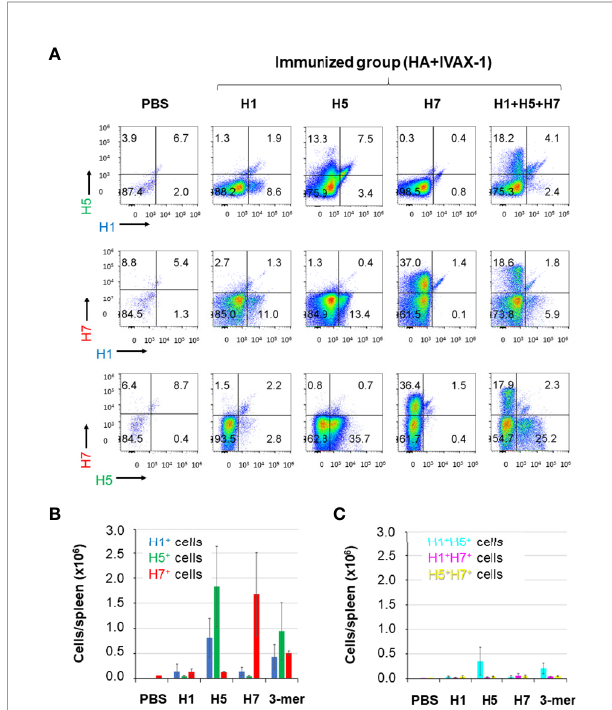
FIGURE 5 | The majority of plasma cells from HA-trimer immunizations are antigen-monospeci fi c. Mice were administered HA trimers individually (H1, H5 or H7; 3 m g per dose) or combined (H1+H5+H7), both in IVAX-1 adjuvant. For B cell labeling, mice were boosted on d45 i.p. with the same formulation, and sacri fi ced 5 days later. Single cell suspensions from individual spleens were surface-labelled with appropriate CD markers(see Materials andMethods ), then fi xed and permeabilized, andprobedwith HA monomers conjugated to fl uorescent dyes to label antigen-speci fi c B cells: H1-DyLight405, H5-DyLight488 andH7-DyLight650. (A) Representative plots of plasma cells(CD138+ CD19lo) from different vaccinegroups, with H1, H5 orH7 fl uorescence indicated on x- andy-axes. (B) Bar graph of the total number (+/-SD) of H1-speci fi c, H5-speci fi c andH7-speci fi c plasma cells per spleen inmiceimmunized as in (A) . (C) Bar graph of the totalnumber of dual-speci fi c (H1+H5+,H1+H7+ and H5+H7+) plasma cellsper spleen inmice immunized as in (A) . Datarepresentative of several replicate